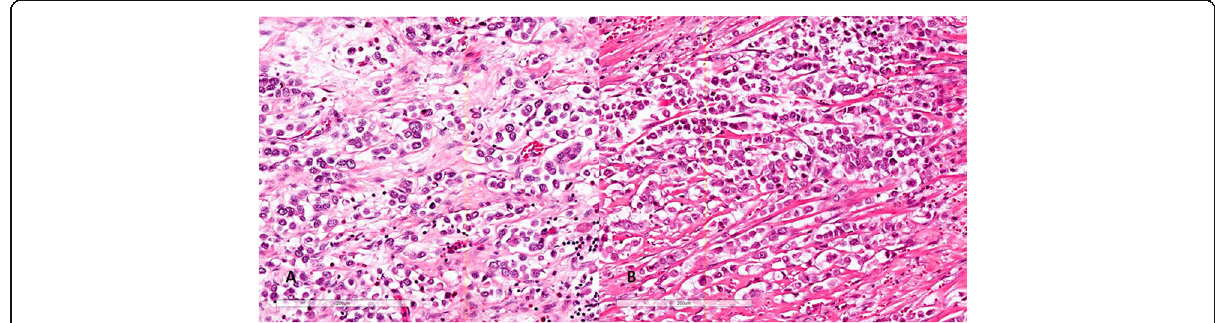
Fig. 1 a and b . PUC characterized by isolated cells with eccentric nuclei with eosinophilic cytoplasm giving them a plasmacytoid